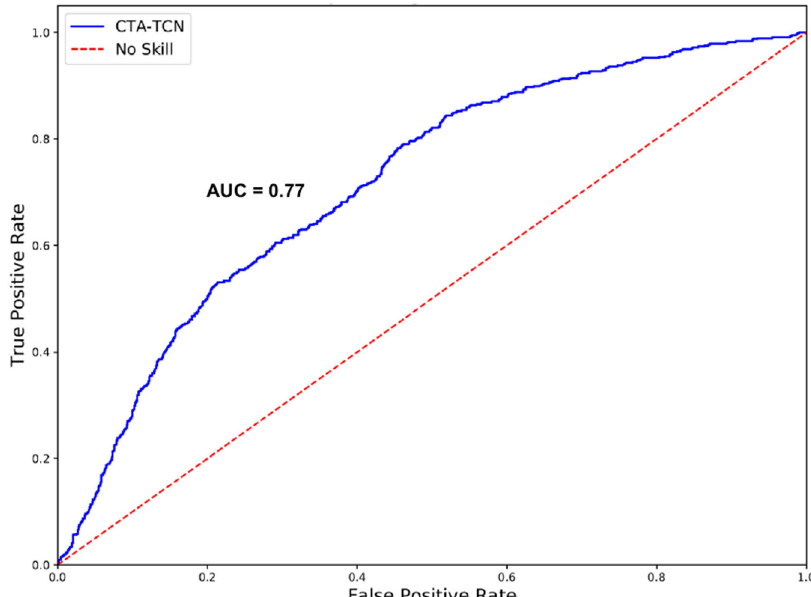
Fig. 2 ROC curve for CTA-TCN model. CTA-TCN Channel-Temporal Attention-Temporal Convolutional Network. AUC Area Under the Curve. ROC Receiver Operator Characteristic.